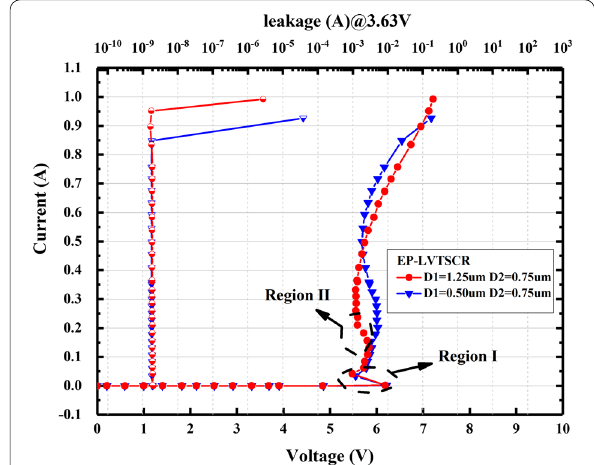
Fig. 6 Measured TLP I–V and leakage currents of EP-LVTSCR with two different D1